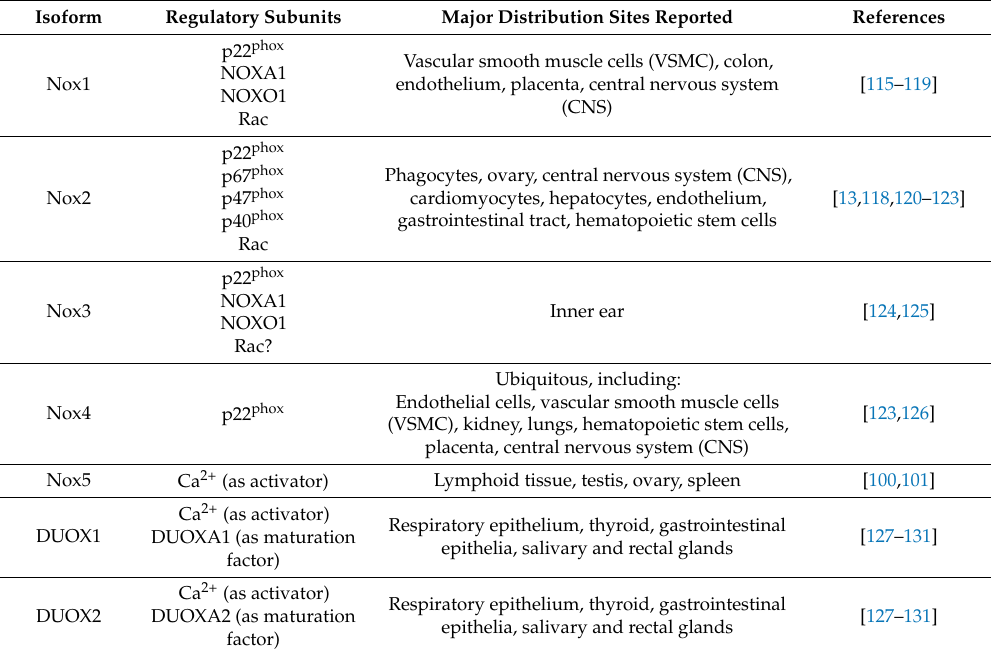
Table 1. The main tissue distribution of NOX isoforms exhibiting plasma membrane